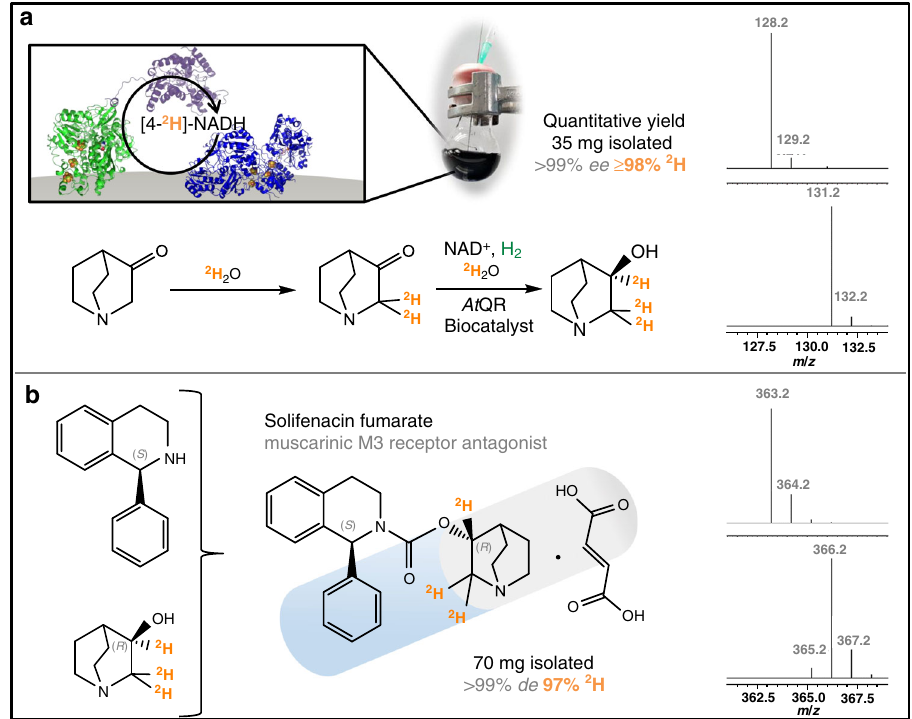
Fig. 4 Scalable biocatalytic deuteration for preparation of heavy solifenacin fumarate. a Preparation of trideuterated ( R )-3-quinuclidinol via biocatalytic reductive deuteration and b incorporation into the pharmaceutical compound (1 S ,3 ′ R )-solifenacin fumarate. In each case, the mass spectroscopy traces show the expected + 3 shift in m / z values of the isolated product (lower plot) relative to their natural abundance standards (upper plot). Full experimental and analytical details are provided in Supplementary